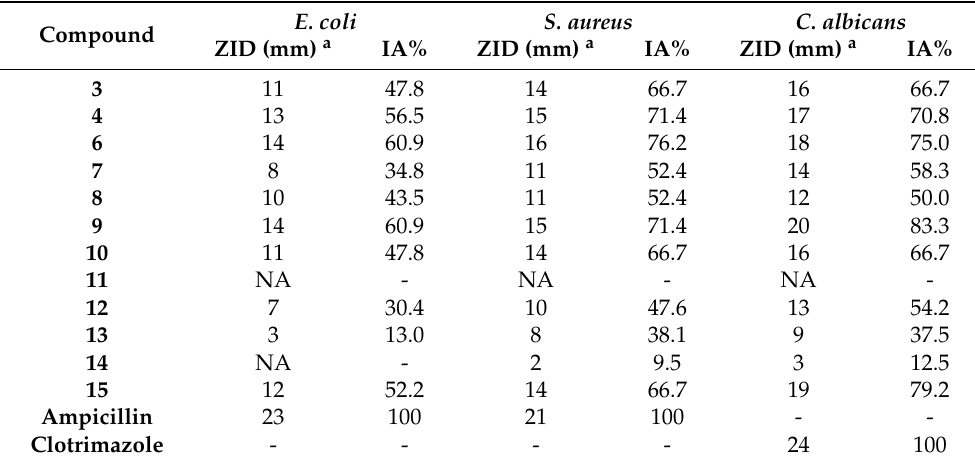
Table 2. The antimicrobial properties of the OSe